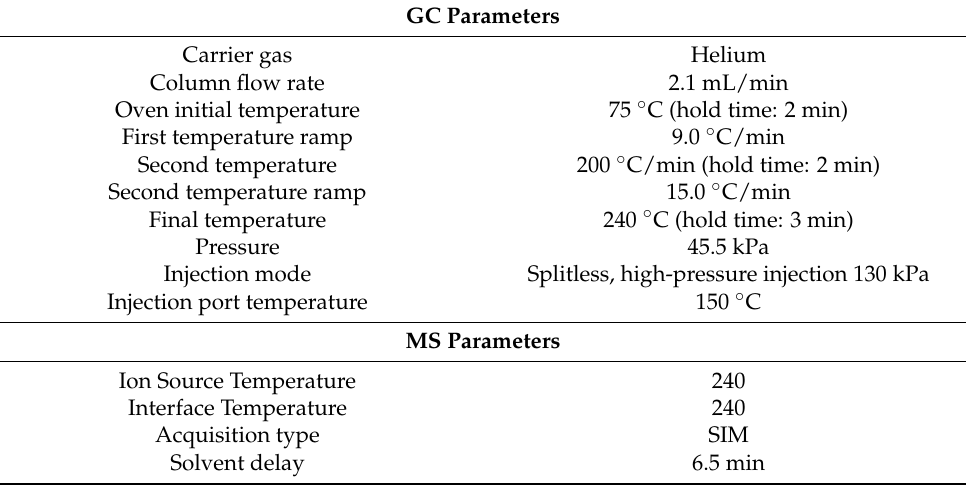
Table 4. GC-MS method experimental conditions.